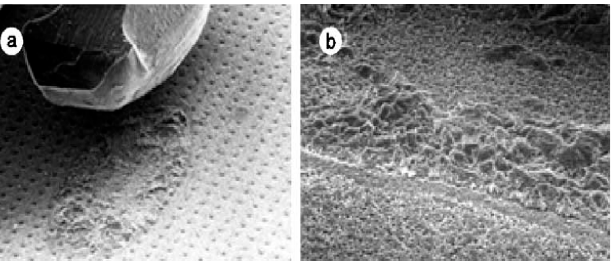
Figure 9. Bond wire failure [63]. ( a ) Bond wire lift-off (SEM image, 40 × ), ( b ) close view of the footprint of an aluminum bond wire after lift-off (SEM image, 100 × ).